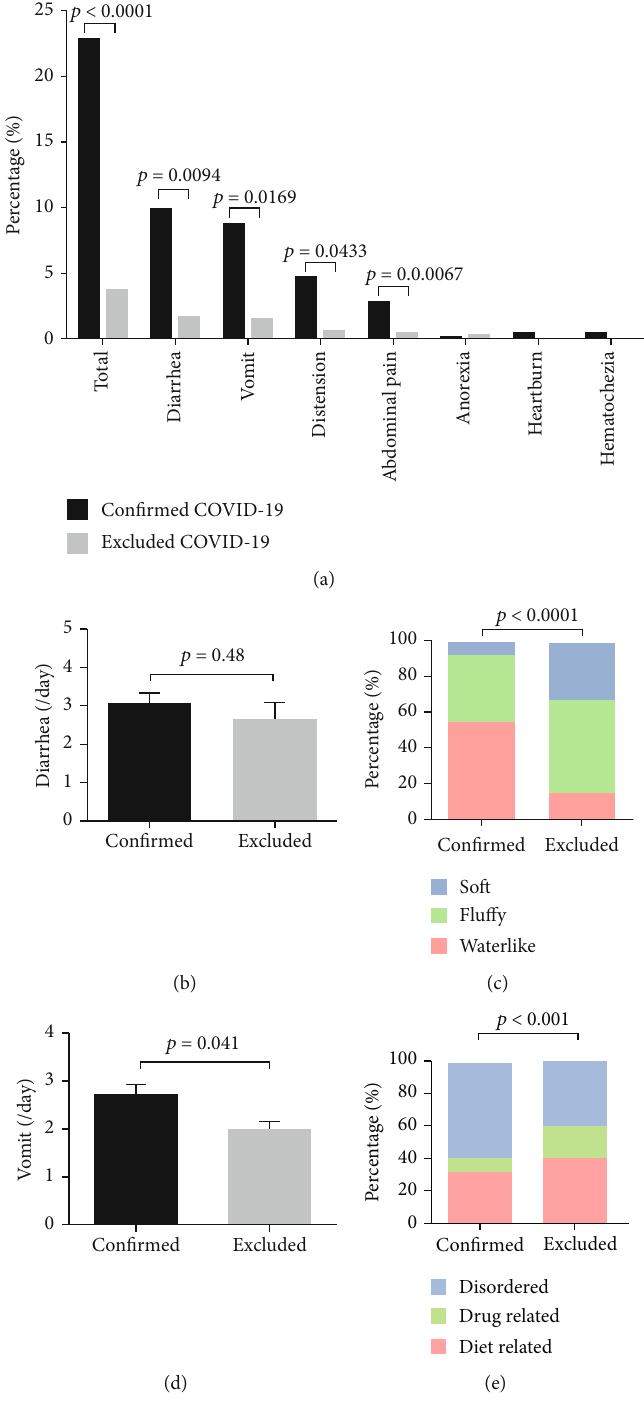
Figure 2: Comparison of digestive symptoms between con fi rmed COVID-19 and excluded cases. (a) Percentage of digestive symptoms were compared between con fi rmed COVID-19 cases and excluded cases. (b) No di ff erence was found in stool frequency. (c) Among those who presented with diarrhea, more con fi rmed patients described watery diarrhea than excluded cases. (d) Con fi rmed COVID-19 patients had higher frequent vomit than the excluded cases. (e) Higher rates of nonfood or drug-related percentage of disordered vomit were